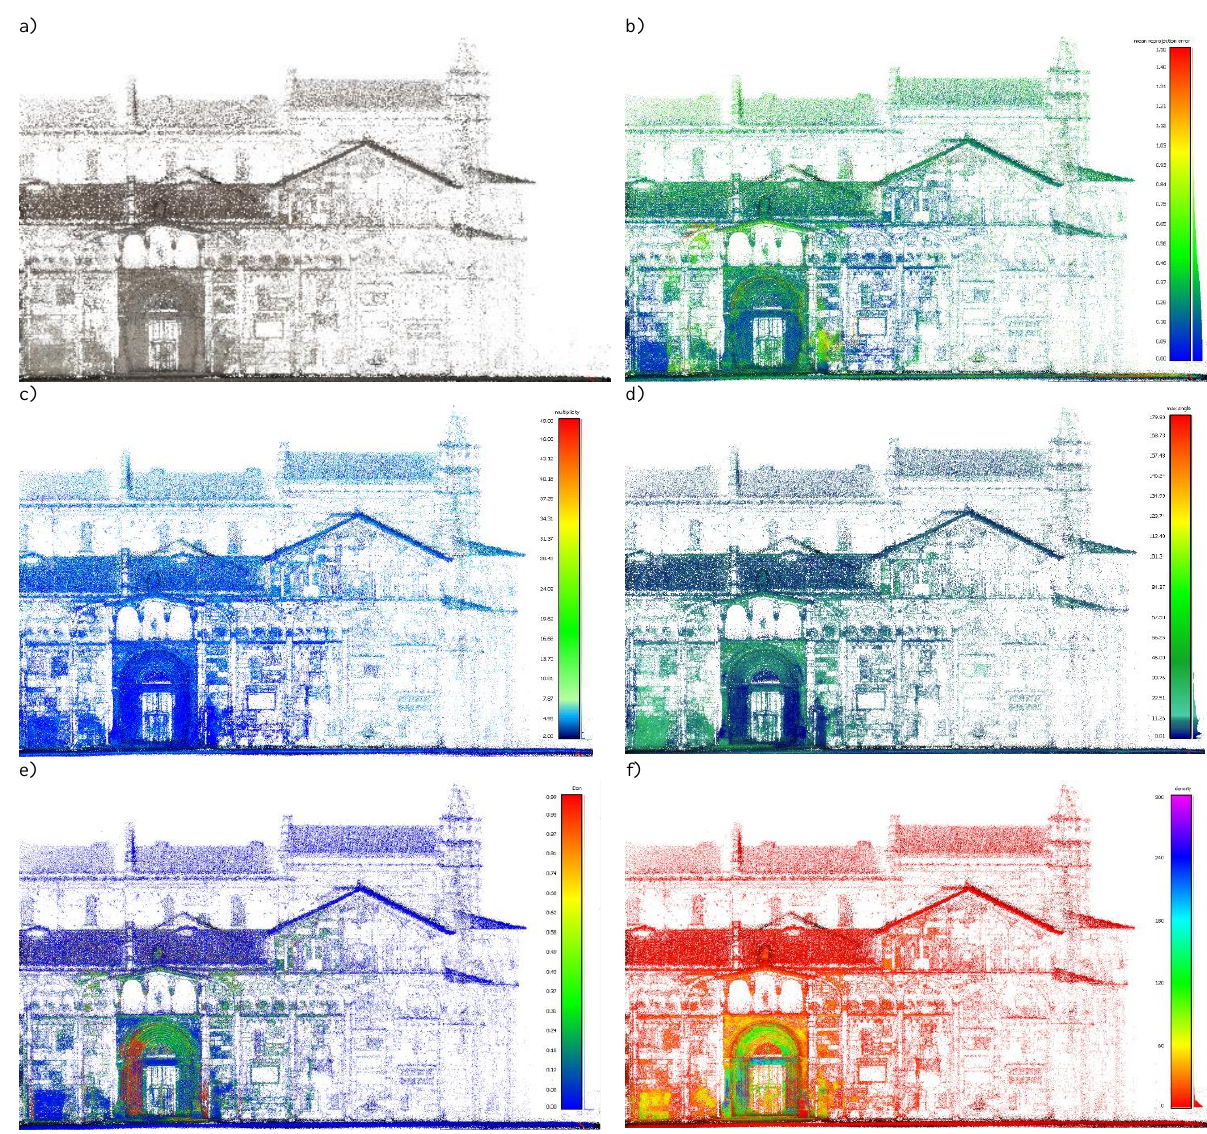
Figure 4: Examples of computed quality features visualized on the sparse point cloud (about 3 million points - a): reprojection error (b), multiplicity (c), intersection angle (d), difference of normals (DoN) (e) and 3D density (f). Please note that the DoN (e) is higher where surface discontinuities are present (i.e. decorations of the main door). The 3D density (f) is higher where multiplicity and intersection angles are also